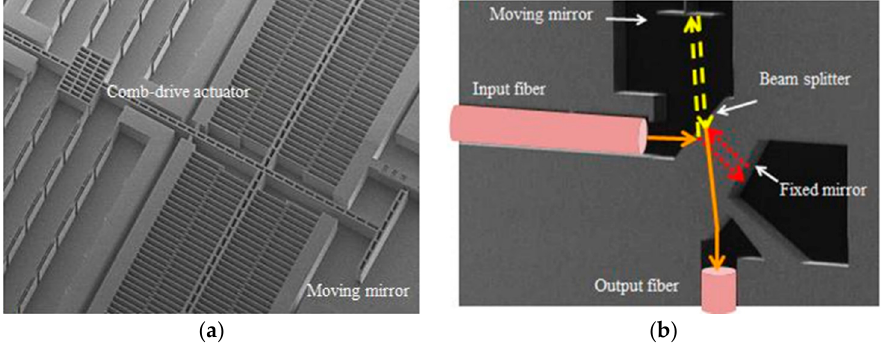
Figure 10. On-chip in-plane electrostatic comb-based FTS: ( a ) Comb-drive actuator; ( b ) optical components. (Reprinted with permission from Reference [35] IEEE). components. (Reprinted with permission from Reference [35] IEEE).